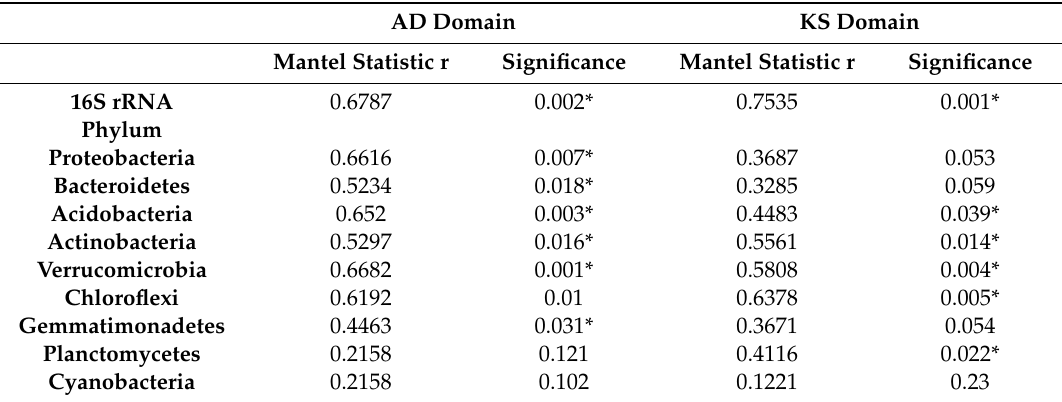
Table 1. Mantel correlation between the 16S rRNA gene diversity and the most abundant bacterial phyla 16S diversity with the AD and KS domain